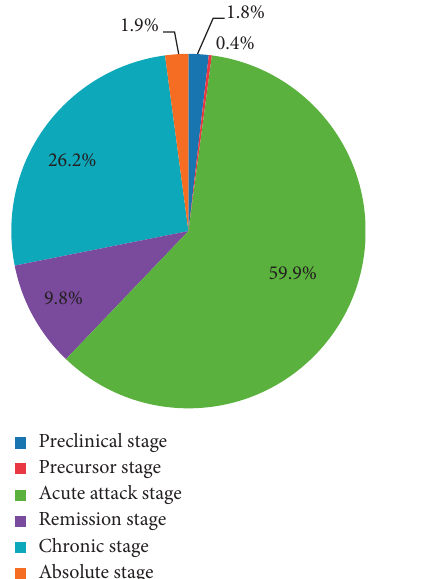
Figure 2: Clinical stages of acute angle-closure glaucoma.